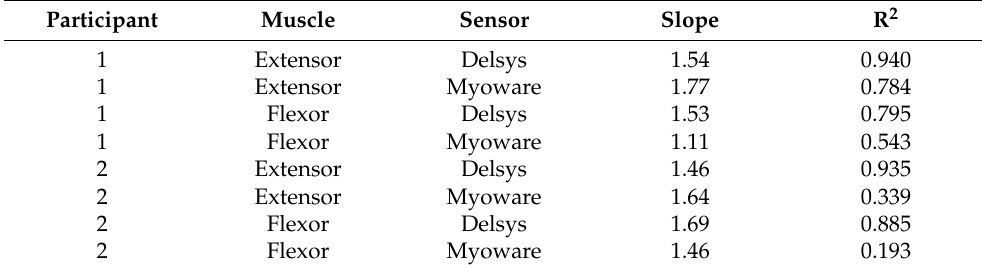
Table 3. Muscle activity correlation with grip force while building-up to a sustained